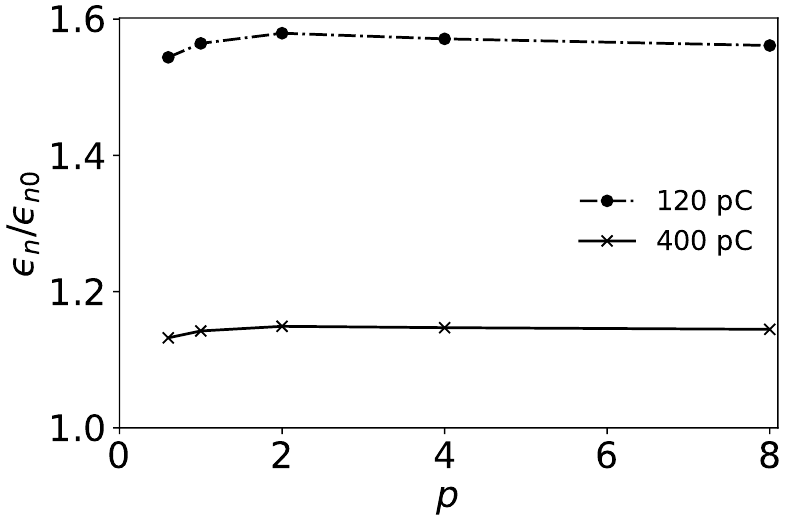
Figure 5. Dependence of the normalized transverse beam emittance (cid:101) n at s = 10 m on the form parameter p of the initial SG distributions for both charge groups (120 pC and 400